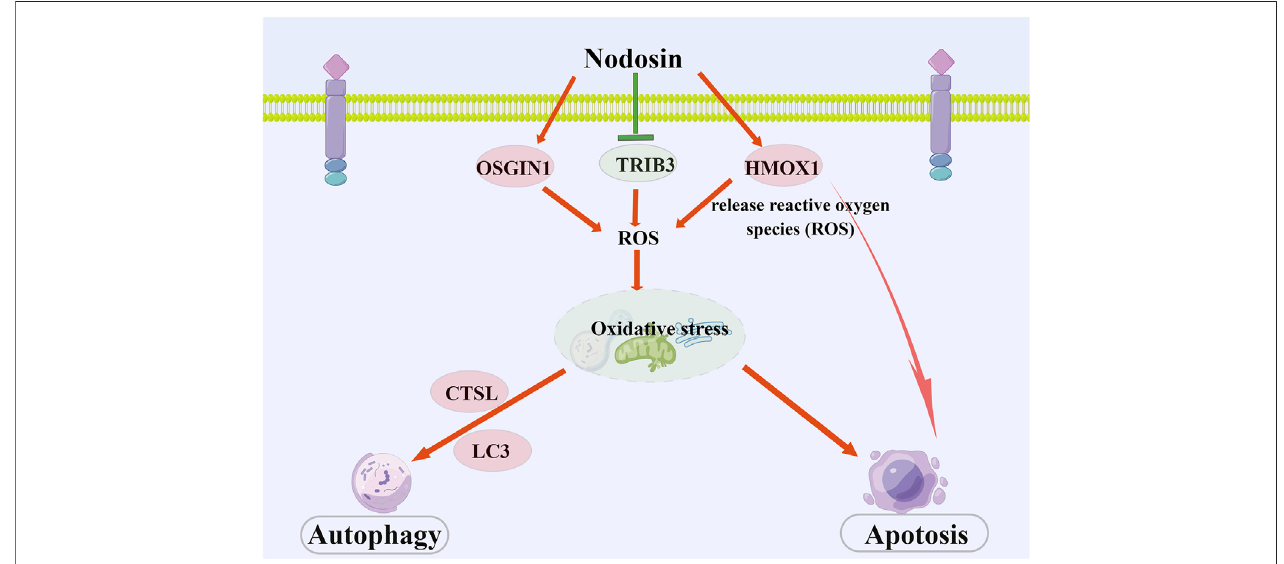
FIGURE 7 | The schematic diagram of pharmacological mechanism of nodosin against CRC. Nodosin inhibited CRC mainly by triggering oxidative stress, apoptosis,and autophagy.Theobservedpharmacologicalmechanism ofaction ofnodosin onCRCisasfollows: 1)Nodosincoulddownregulate TRIB3and upregulate OSGIN1 to elevate ROS levels and induce oxidative stress in cells. Moreover, nodosin could upregulate HMOX1, induce heme breakdown, release ROS, promote oxidative stress in cells, and induce apoptosis. 2) Excessive ROS production could lead to oxidative stress in cells. Oxidative stress was able to induce apoptosis. Finally,mitochondriaandendoplasmicreticulumweredestroyedinresponsetooxidativestress.Lysosomesremoveddamagedorganellesandinducedcellstoundergo autophagy, inducing upregulation of autophagy markers LC3 and CTSL expression. Nodosin promoted cell death by inducing CRC cells to undergo apoptosis and autophagy. This fi gure is drawn by Figdraw (www. fi gdraw.com).